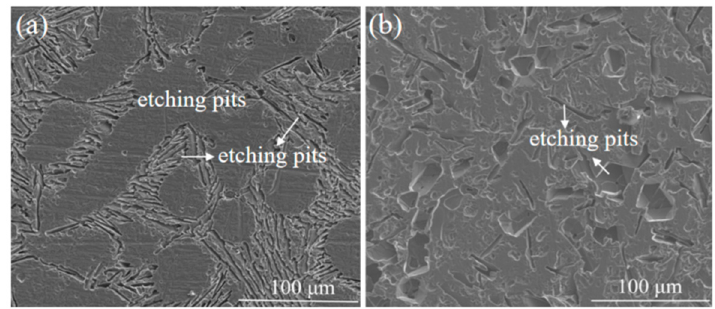
Figure 11. Surface morphology of ( a ) Al-9 Si and ( b ) Al-15 Si with 60 s etching treatment.